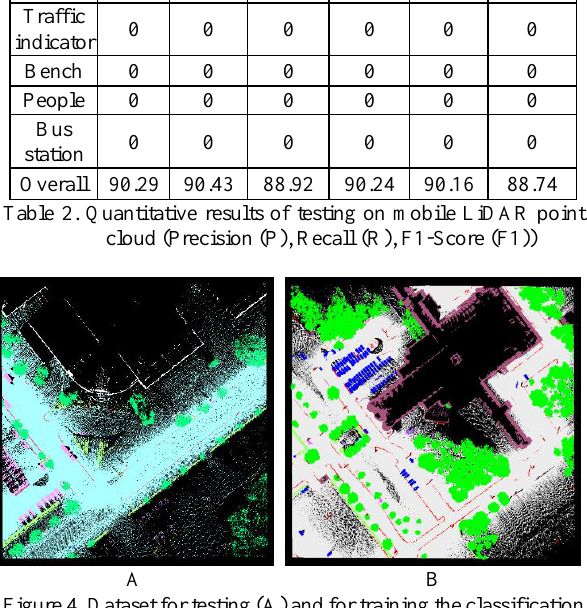
Figure 4. Dataset for testing (A) and for training the classification model